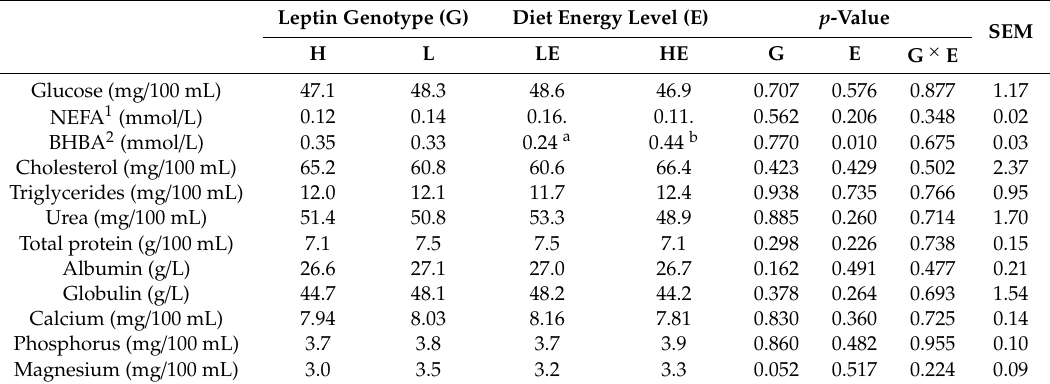
Table 3. E ff ect of leptin genotype and energy level of diet on blood metabolites.